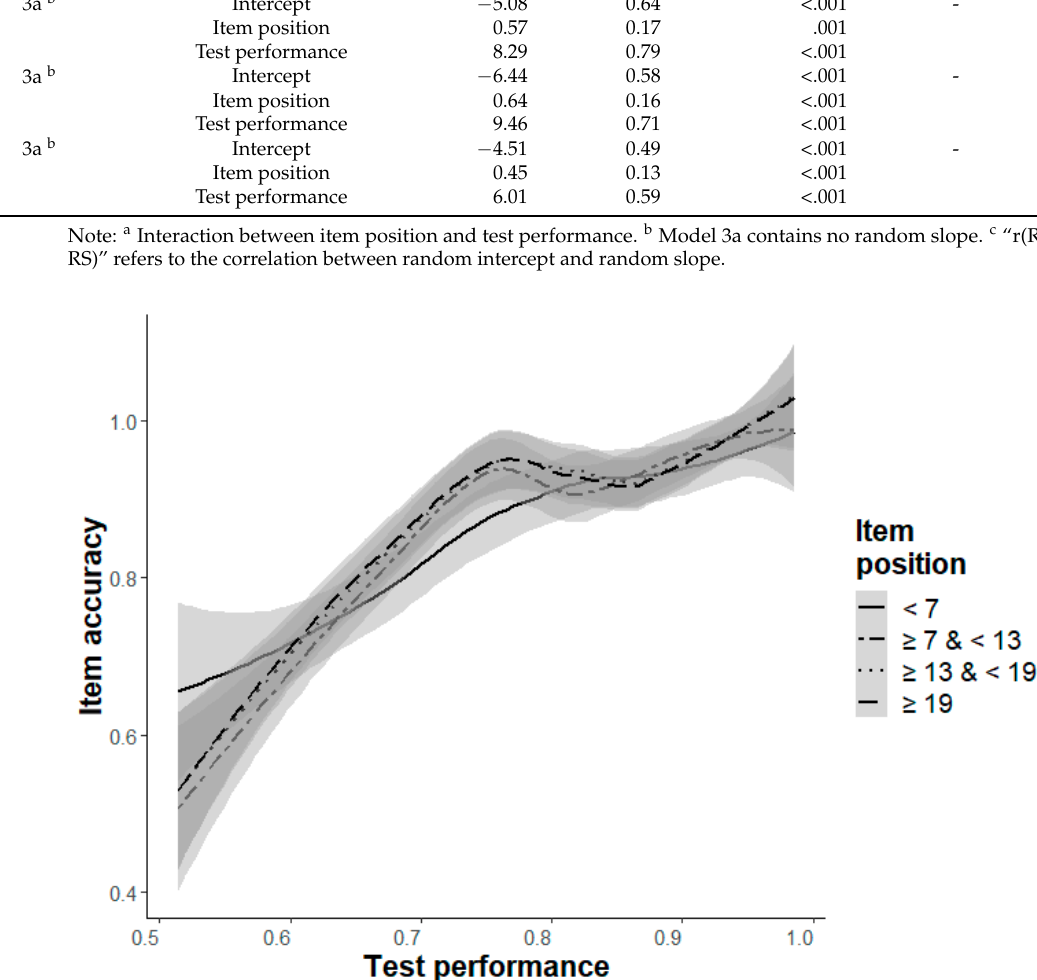
Table 4. Fixed e ff ects and correlations between random intercept (RI) and random slope (RS) of the MLM with the dependent variable reaction times.